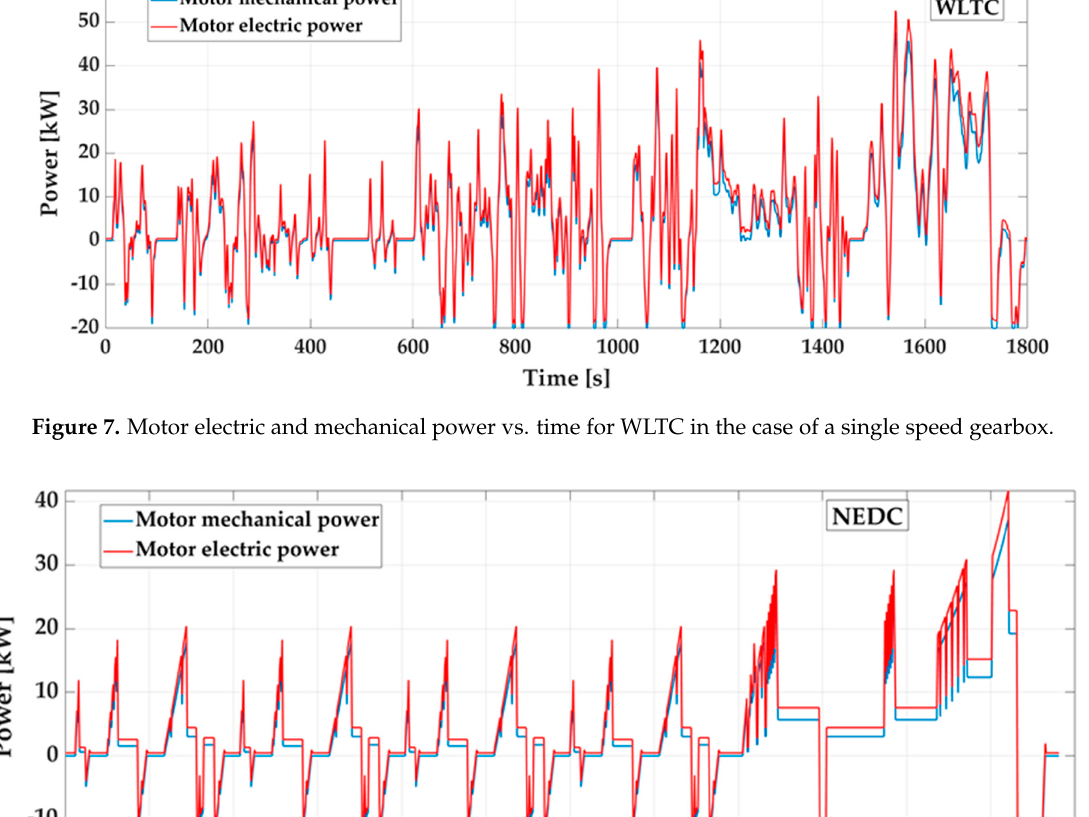
10 of 17 Figure 6. Cumulative energy consumption vs. transmission second gear ratio for different switch- ing speed over WLTC. The result revealed that for each switching speed there is a gear ratio that offers min- imum energy consumption by the driveline. However, this gear ratio depends on switch- ing speed. We observed a low impact of gear ratio and switching speed for a ratio of more than 5. Low values of gear ratio, below 4, led to high impact on energy consumption, especially for a switching speed below 60 km/h. The combination of gear ratio and gear switching speed that offers minimum cumulative energy is 4.5 and 50 km/h. These values are further used in order to evaluate the dual speed transmission compared to single speed. It can be observed that in this case the single and dual speed transmission has nearly the same efficiency, since only gear can operate at a time. This phenomenon is addressed in the literature in multiple studies [12–16]. The appropriate operation of single and dual gearboxes can be achieved for electric vehicles. Thus, when using multiple speed trans- mission, the operating modes have approximately the same efficiency. 5.2. Vehicle Power Demand A numerical study was carried out over the test cycles presented above, taking into account the motor efficiency. Thus, the vehicle mechanical power for driving as well as the motor electric power were estimated. The braking energy that could be recovered in the case of electric propulsion was also considered. During the braking phases, it was as- sumed that the vehicle can stop to zero only by means of the electric machine. However, the motor braking power was limited to 20 kW. For each driving cycle, two cases were